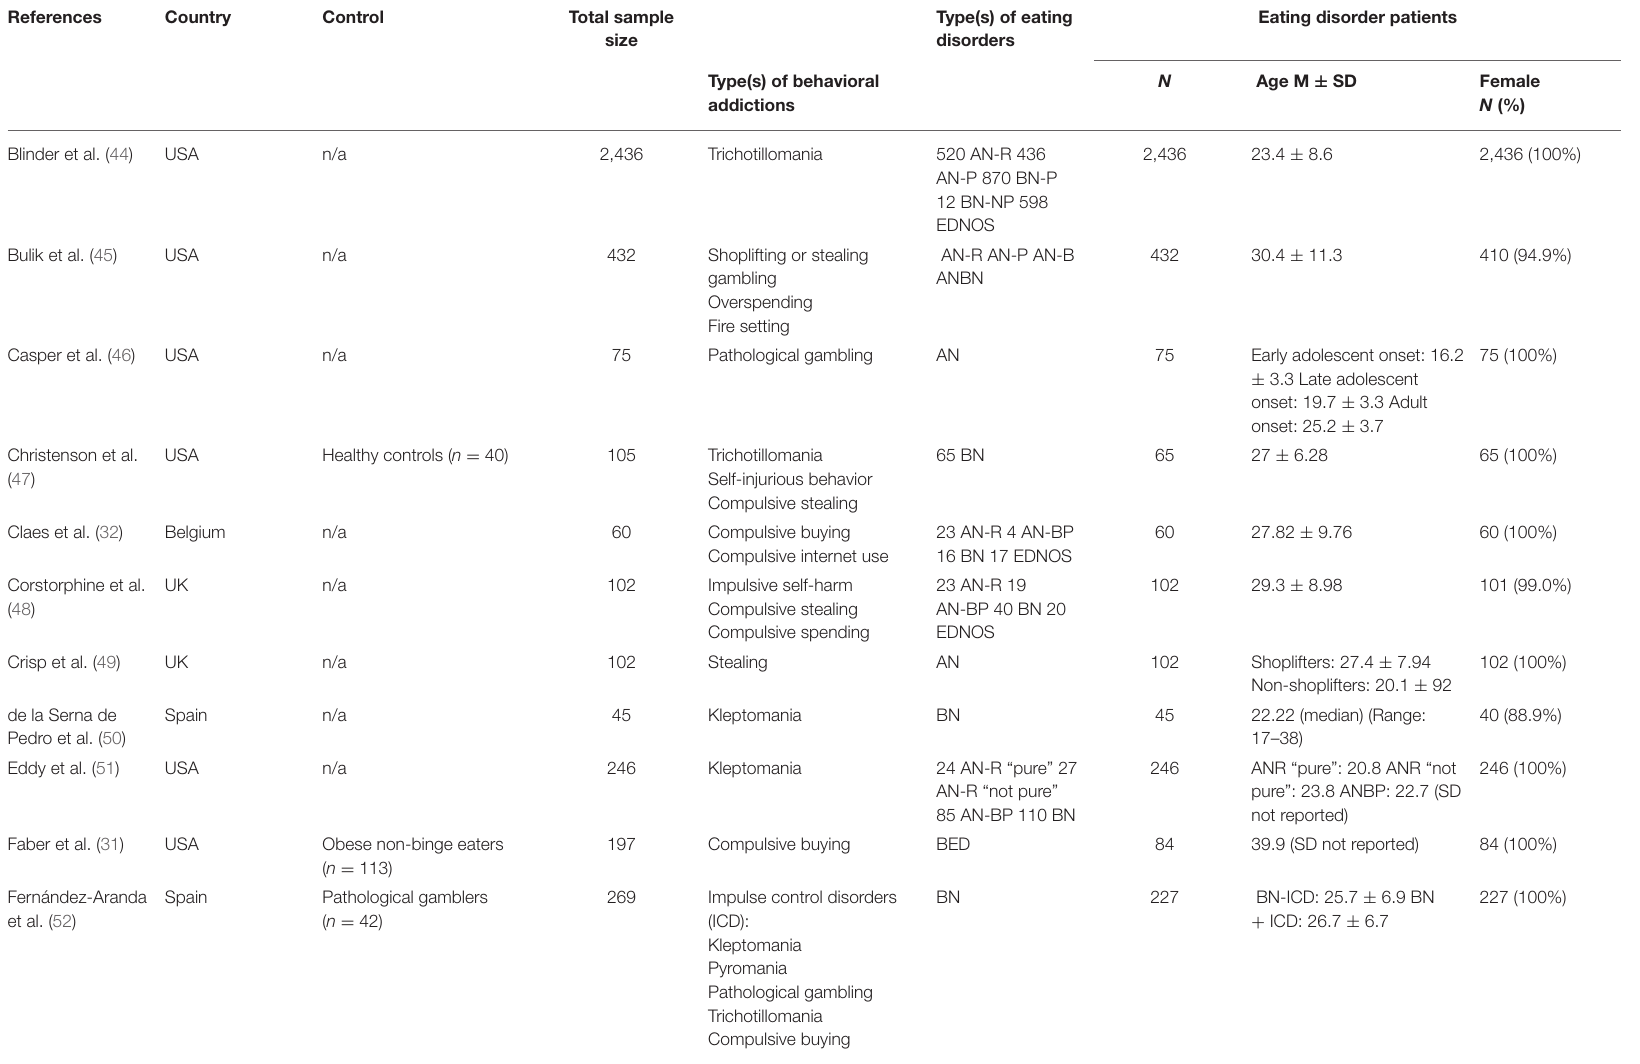
TABLE 1 | Study and participant characteristics of included studies ( N =